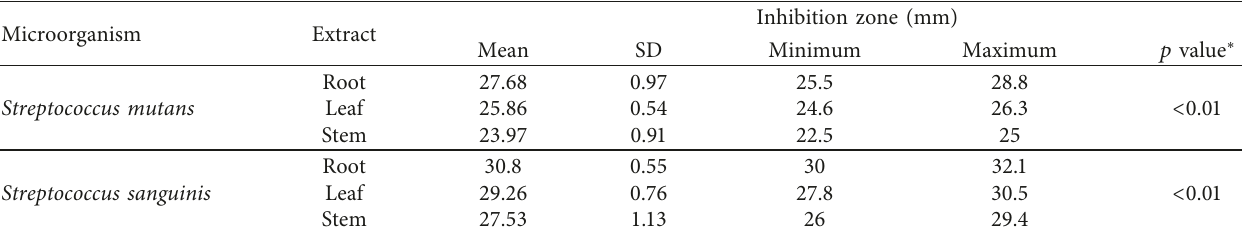
Table 1: In vitro comparison of the antibacterial effect of the methanolic extracts of Pelargonium peltatum against strains of Streptococcus mutans and Streptococcus sanguinis. Microorganism